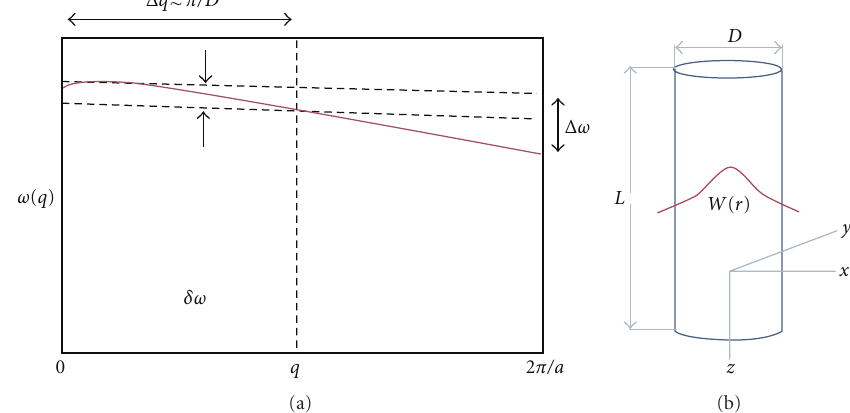
Figure 5: (a) Optical phonon dispersion ω ( q ) of Si with the first order Raman scattering phonon frequencies extend throughout Δ ω . Raman active wavevectors of a nanowire with diameter D lie within Δ q . (b) Schematic of nanowire of diameter ( D = 2 r ) and length L and the confined phonon wave function, W ( r ).